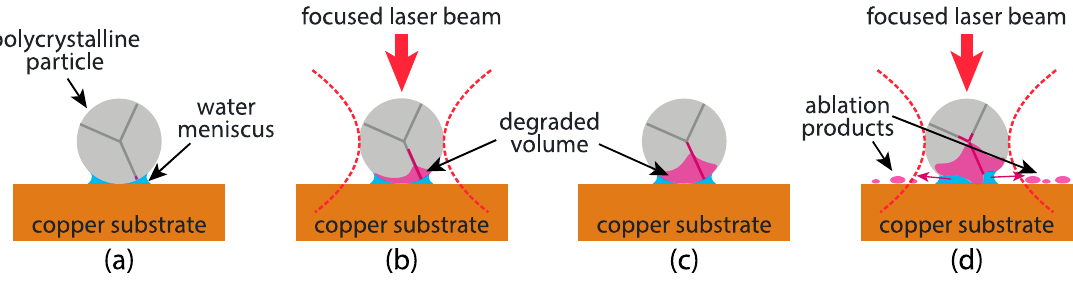
Figure 4. Schematic illustration of the laser-stimulated degradation of a polycrystalline particle on a copper substrate: ( a ) before the initial measurement, ( b ) during the first laser action, ( c ) after the first laser action, ( d ) during the repeated measurement. The dotted red line illustrates the geometry of the laser beam.